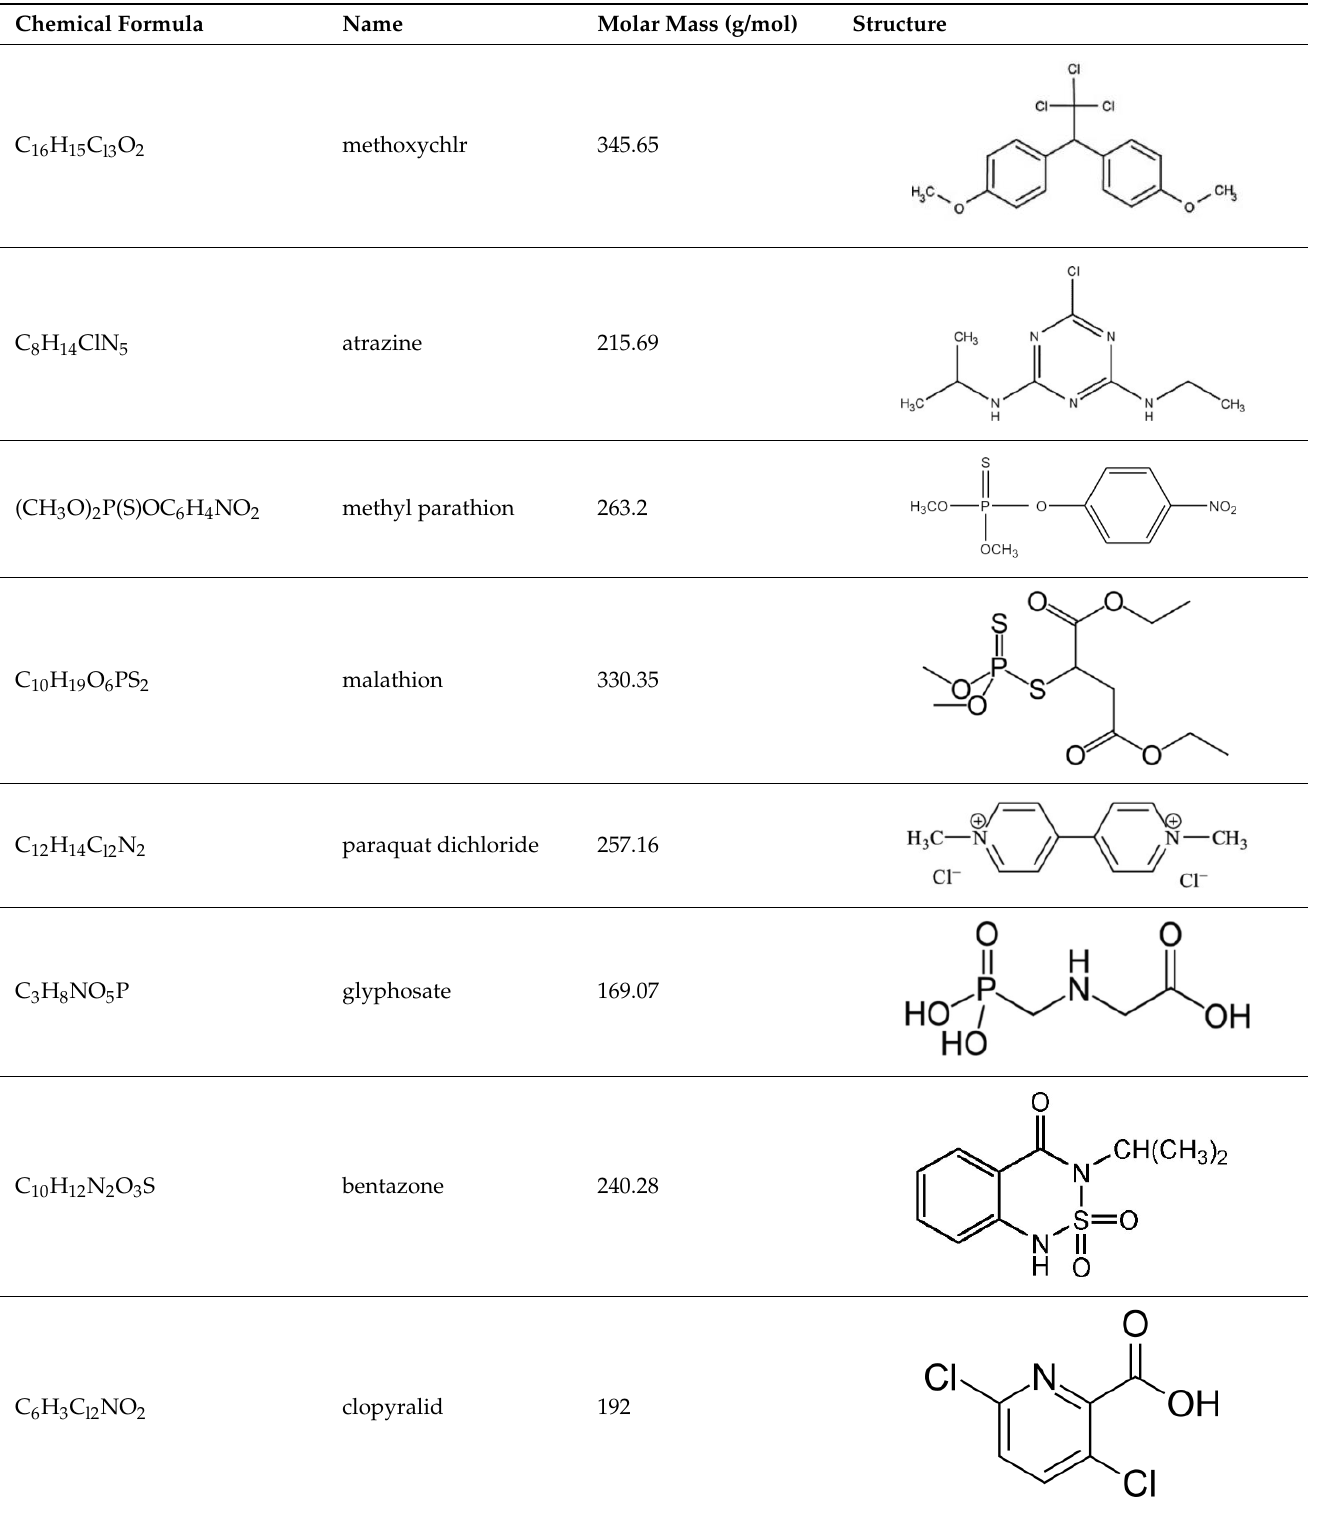
279.33 Table 7. World Health Organization highlighted classification of pesticides [92]. WHO